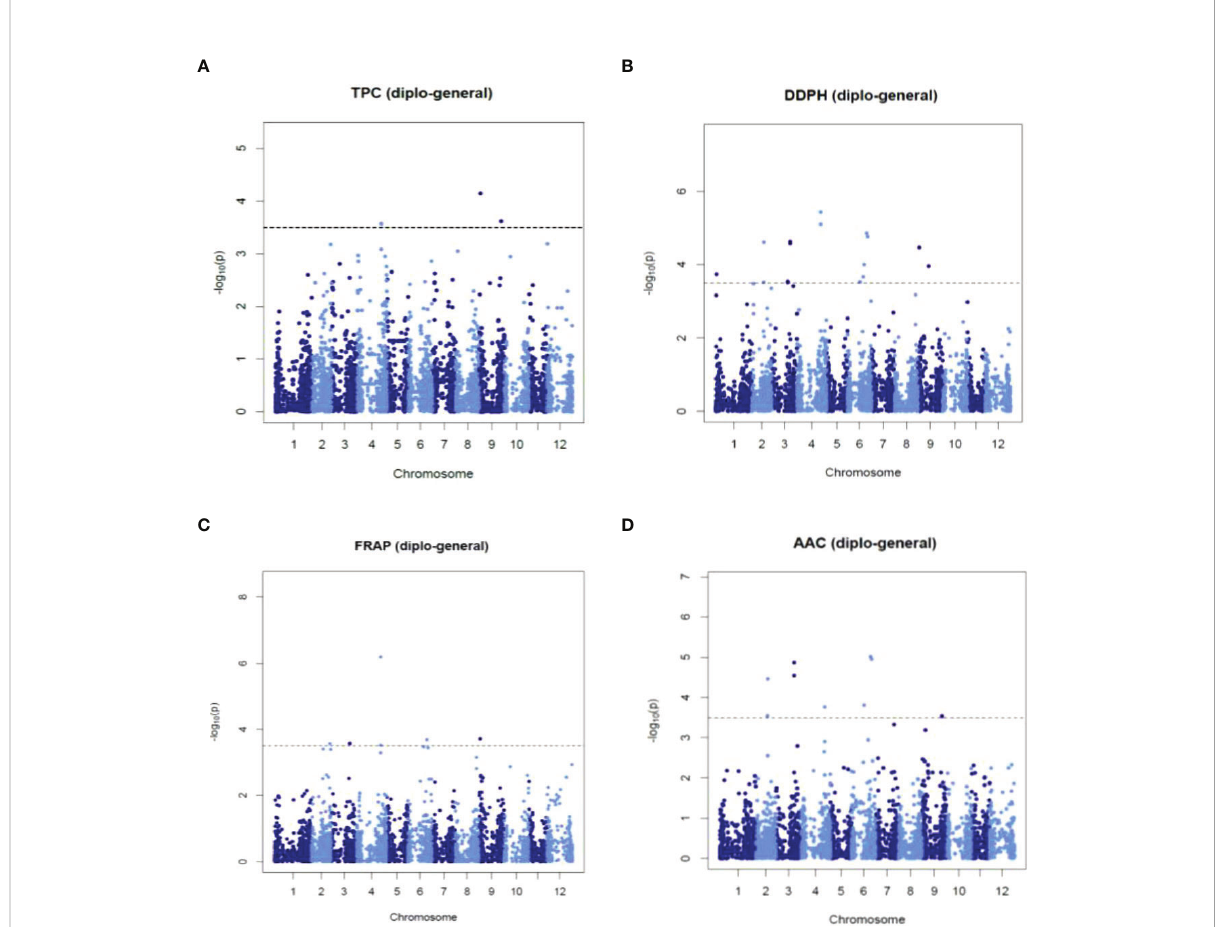
FIGURE 5 Manhattan plots showing signi fi cant STAs for TPC (A) , AA_DPPH (B) , AA_FRAP (C) , and AAC (D) obtained using single-locus GWAS methods in the mixed